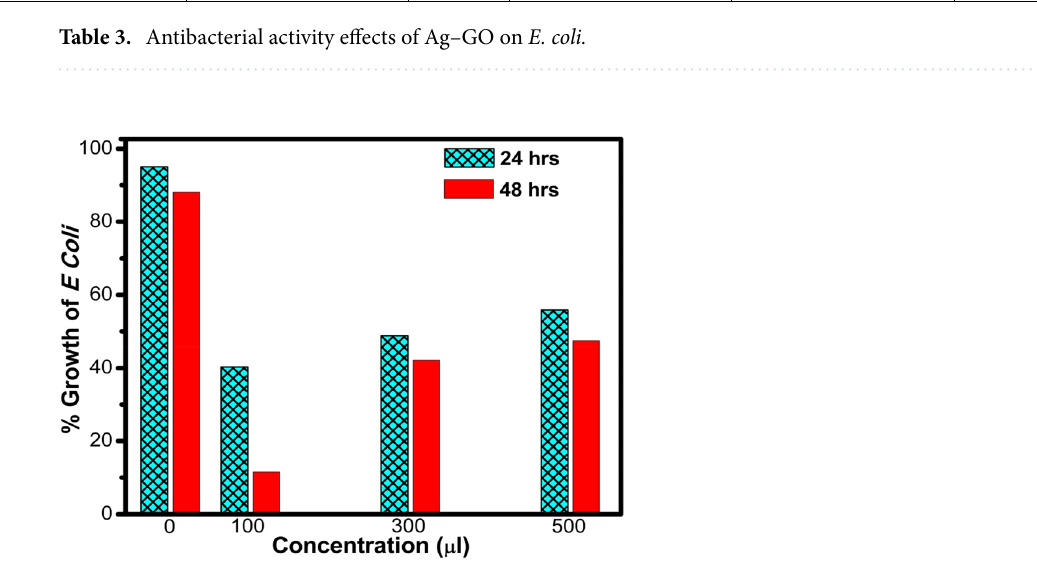
Figure 8. Percentage growth of E. coli treated with different concentrations of Ag–GO